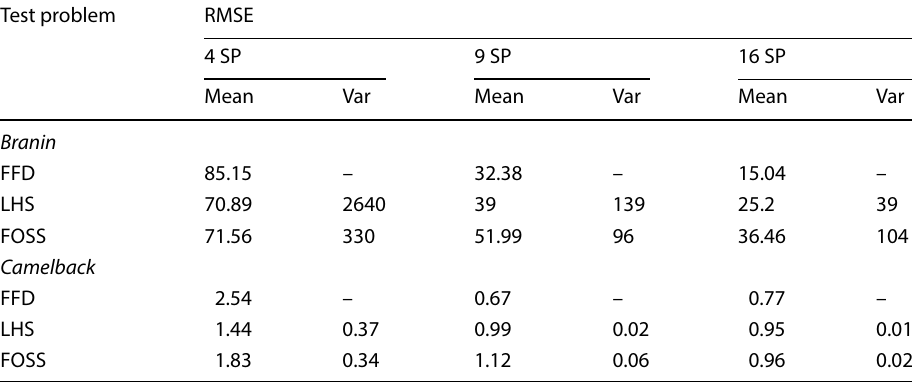
Table 1 Average RMSE for a RBF surrogate based on FFD, LHS and FOSS with 4, 9 and 16 sampling points(SP)